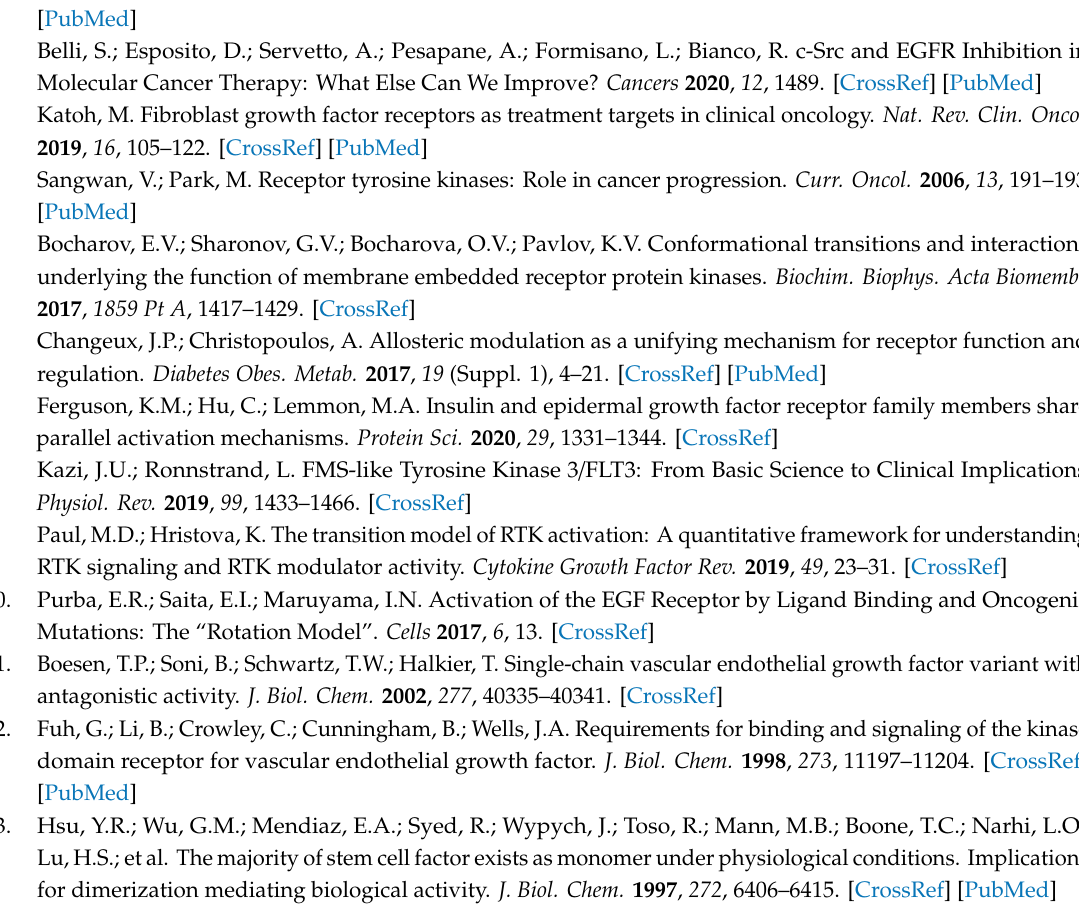
Supplementary Materials: The following are available online, Figure S1: YSD; Figure S2: Binding analysis of individual SCF variants to soluble c-Kit; Figure S3: Protein production and purification; Figure S4: CD spectra of the purified proteins; Figure S5: Schematic representation showing the locations of SCF mutations in the SCF / c-Kit complex (PDB: